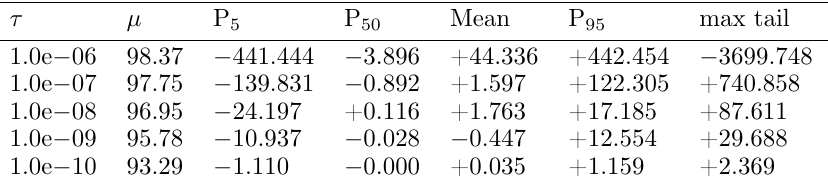
Table 11. Error on k ∞ in pcm after lossy compression by truncated HT on the MOX dataset with matrices M per reaction type only.